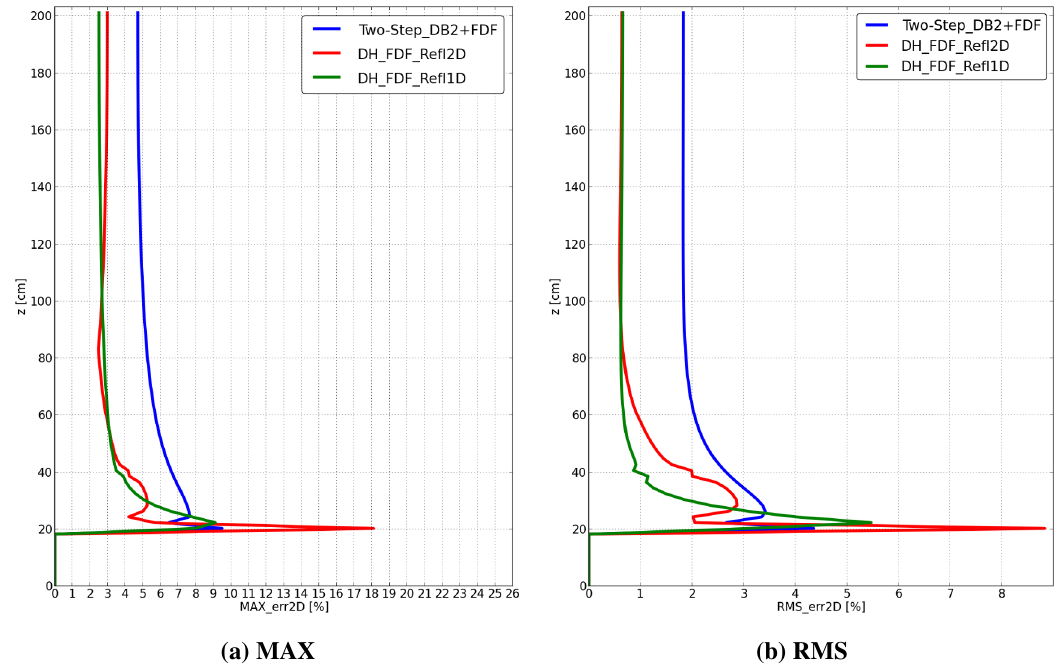
Figure 3: Absolute MAX and RMS of power relative error per radial plane as a function of z for the bottom part of the